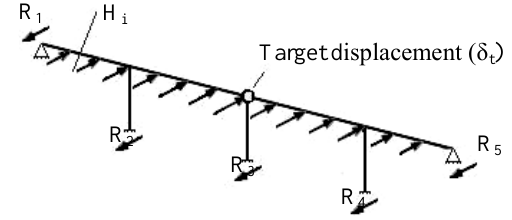
Fig. 1. Summations of support reactions as the base shear and target displacement at center of